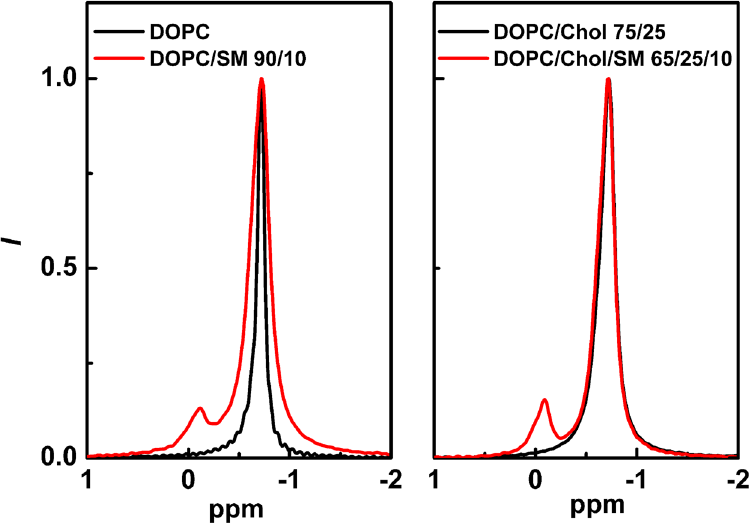
Figure 6. Change in the MAS 31 P NMR spectra after addition of 10% of SM into DOPC (left panel) or DOPC/ Chol (75/25) (right panel) lipid